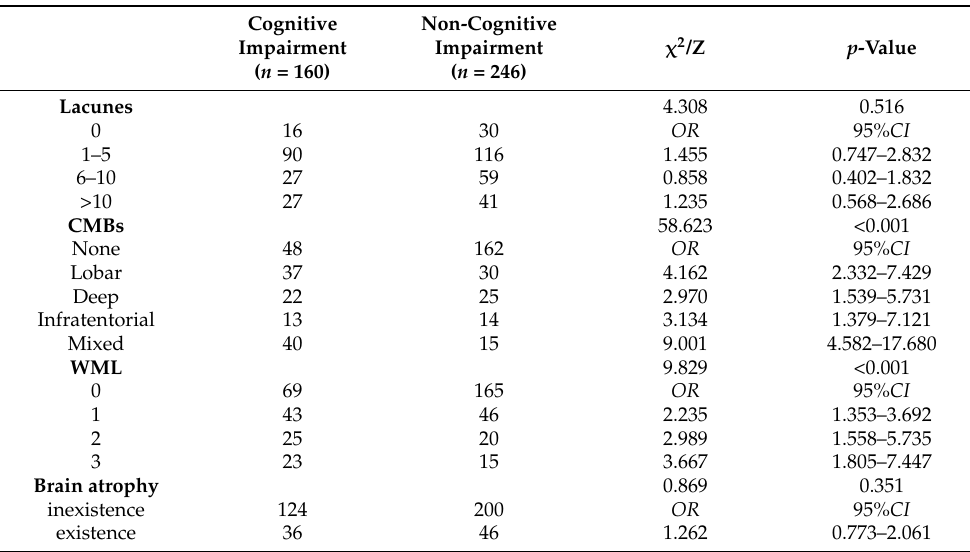
Table 6. Imaging characteristics of the study population grouped according to whether subjects experienced cognitive